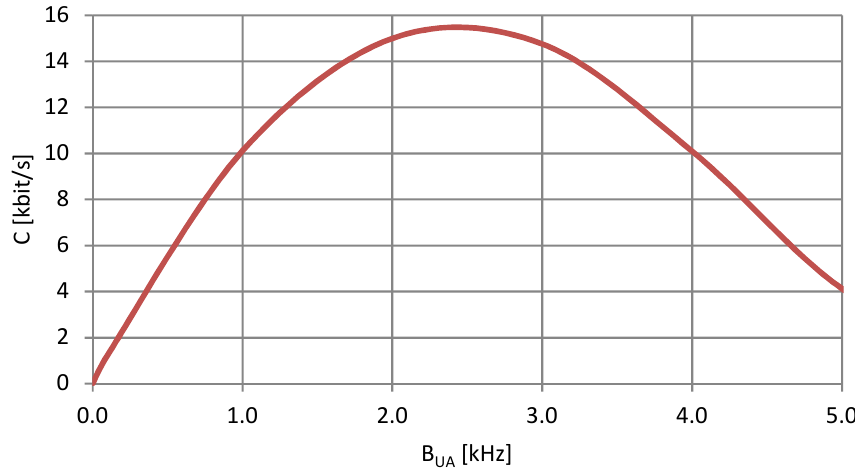
Figure 16. The value of the channel capacity as a function of the bandwidth for the IGLUNA 2019 longwave system.